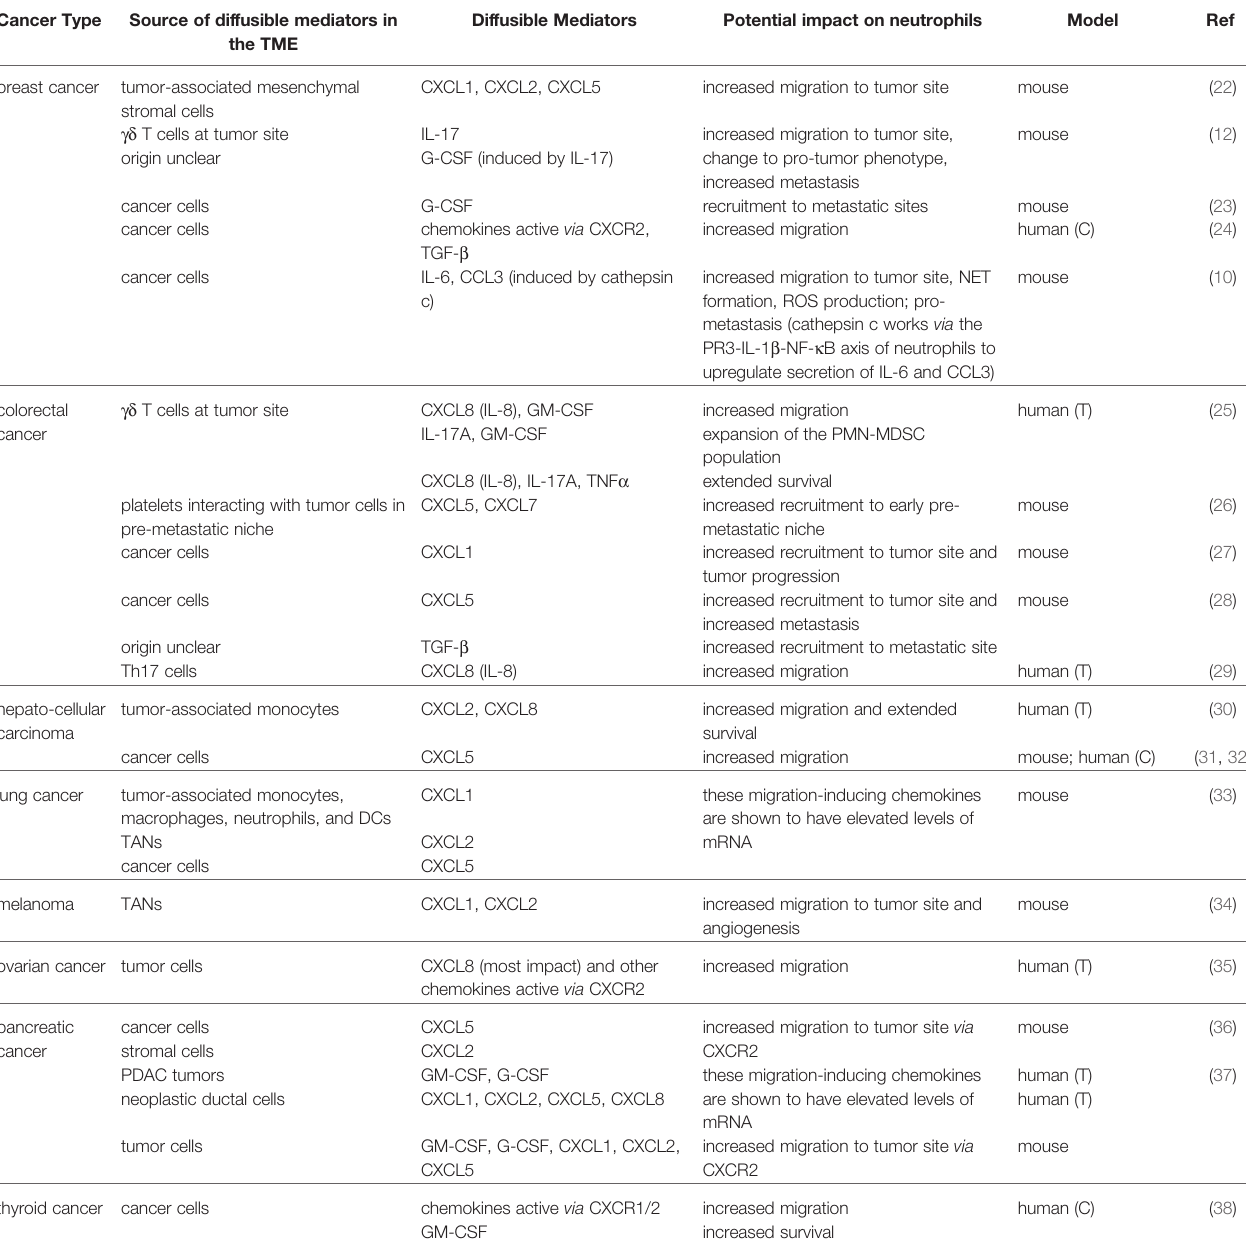
TABLE 1 | List of diffusible mediators along with their cellular origin, potential impact on neutrophils and tumor progression, and the study models. Cancer